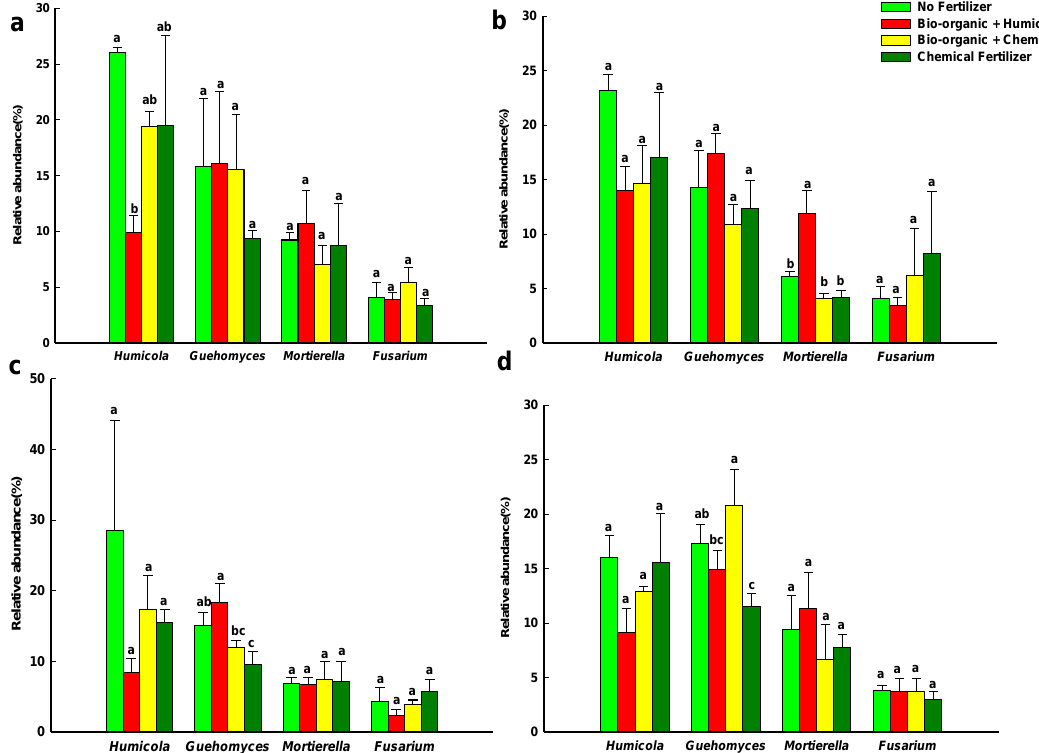
Figure 4. The impact of di ff erent fertilization methods on the relative abundances of the top four fungi genera during stage of ( a ) seedling, ( b ) jointing stage, ( c ) heading period, and ( d ) maturity. Values are mean and standard deviation ( ± SD, n = 3), di ff erent letters correspond to significantly di ff erent values as determined via one-way ANOVA ( p < 0.05).